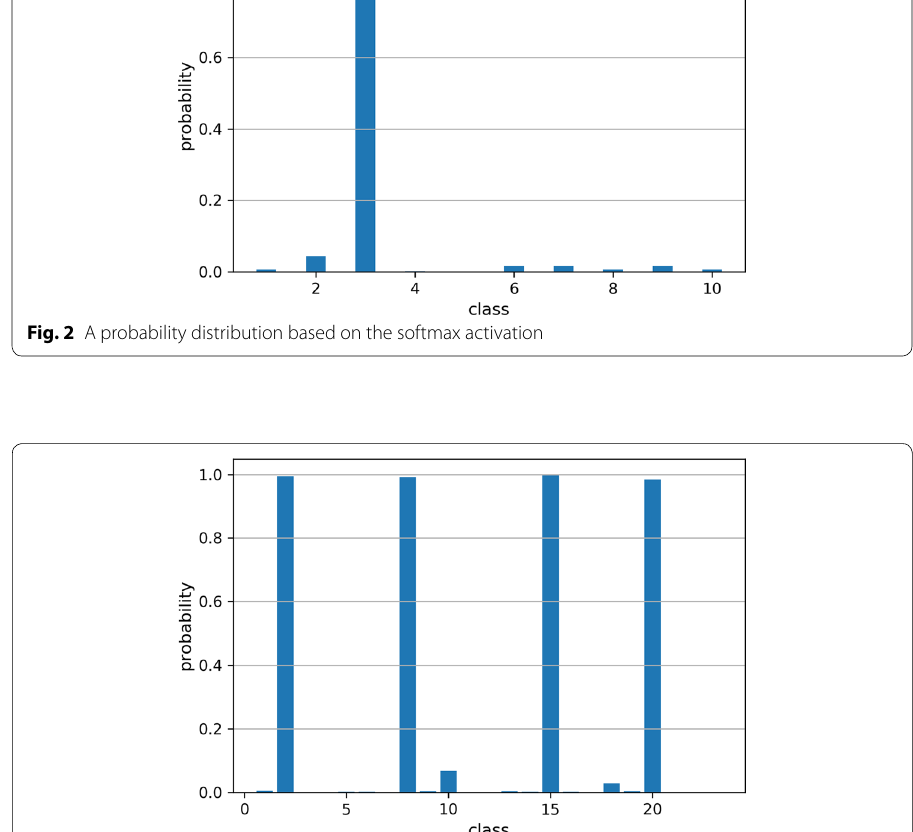
Fig. 3 A group of probabilities based on the sigmoid